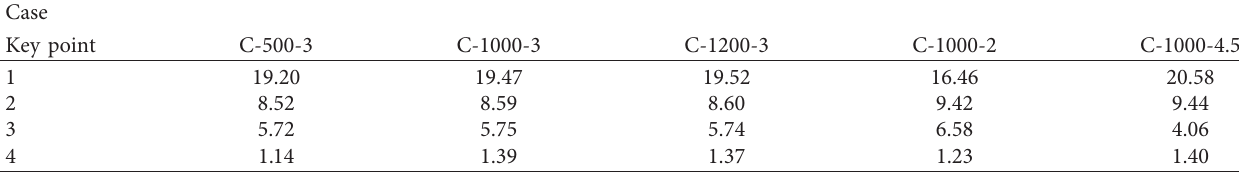
Table 3: The sample points for